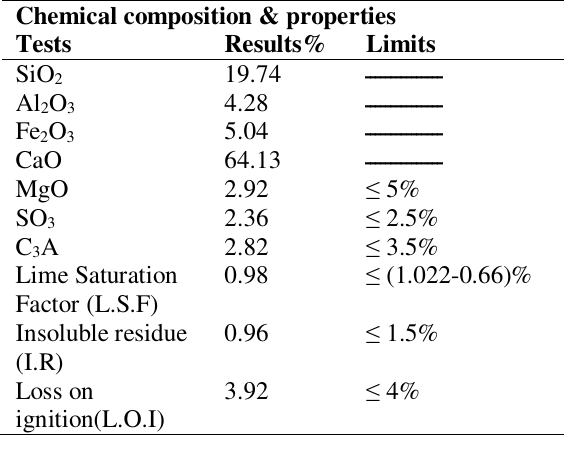
The results of sieve analysis process.